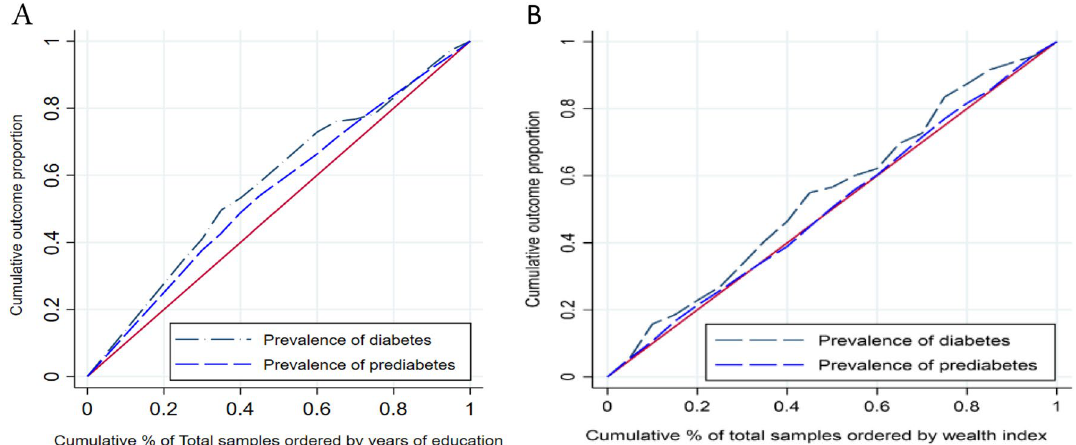
Figure 2. Concentration index for prediabetes and diabetes according to the education years ( A ) and wealth index ( B